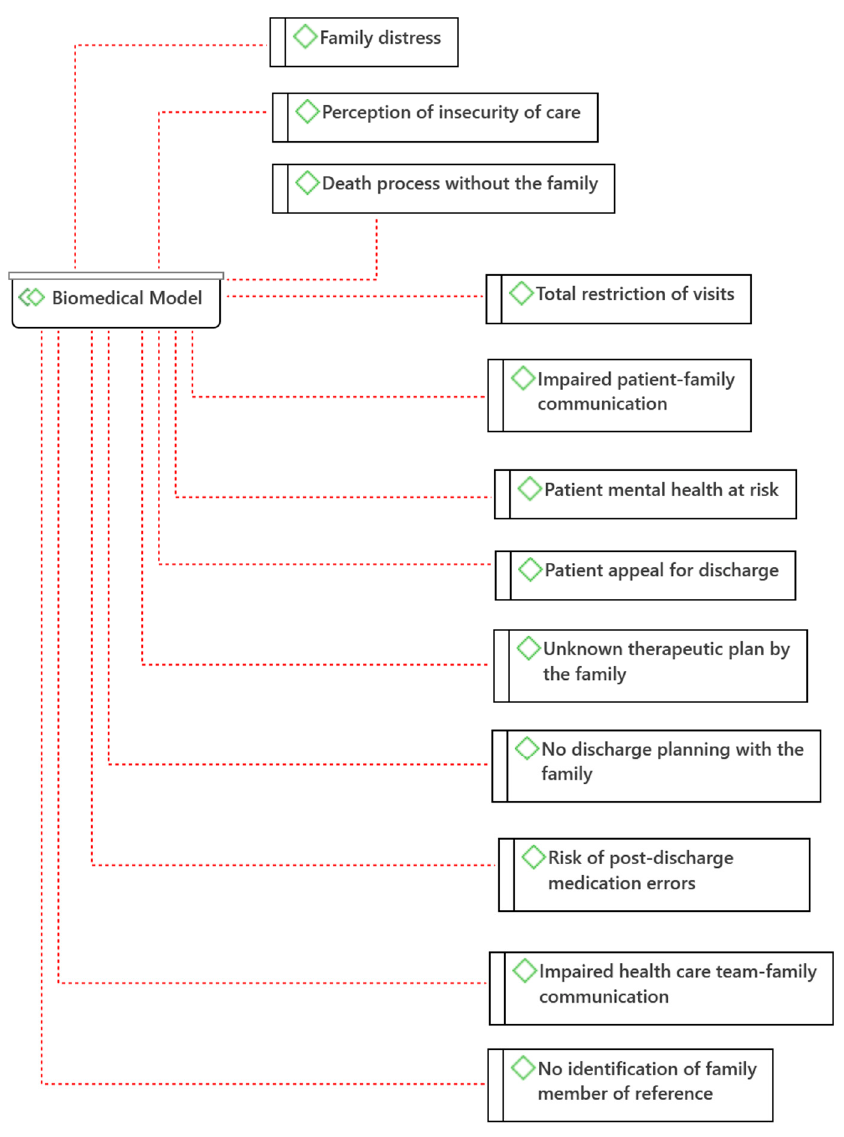
Figure 3. Biomedical Model Categories (Atlas.ti ® ).